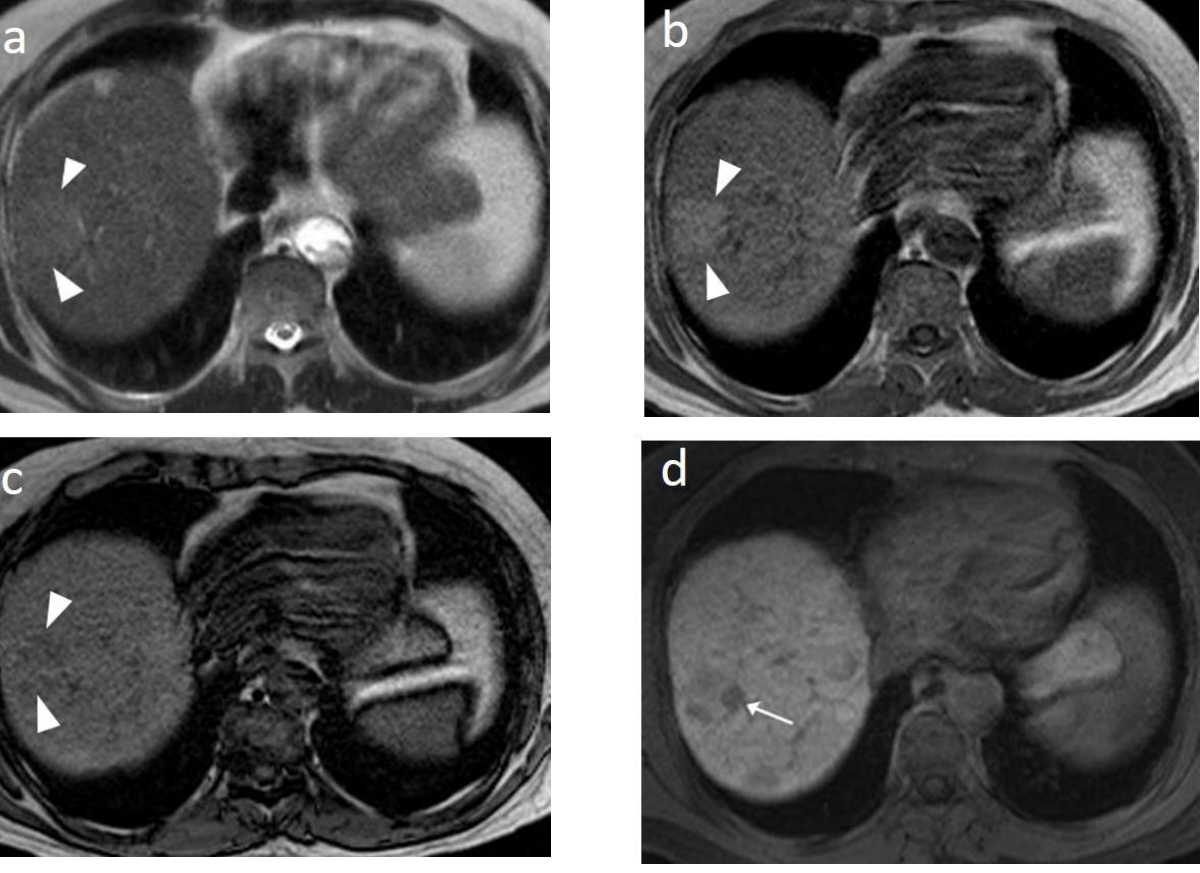
Figure 13. Sixty-five-year-old man with cirrhosis. On the T2 sequence, a nodular high T2 lesion is vaguely seen (arrowheads) ( a ). The lesion appears hyperintense on the in-phase image ( b ) and slightly hypo-intense on the out-of-phase image (arrowheads) ( c ), suggesting the presence of fat. On the hepatobiliary phase after gadoxetic acid administration, a small nodule with markedly decreased signal (no contrast uptake) is evident in the left aspect of the larger lesion (arrow), suggesting focal de-differentiation in a dysplastic fatty nodule and early HCC formation (“nodule in nodule” sign) ( d ).